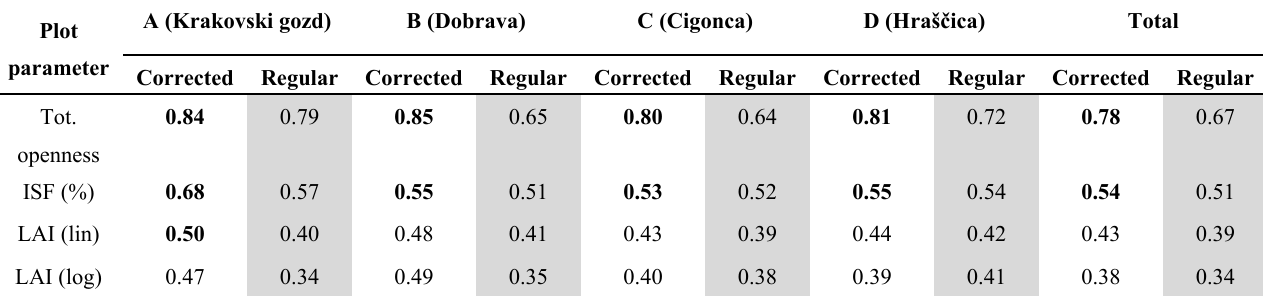
Table 2. Correlation coefficients ( r 2 ) for the agreement between average ocular estimate and parameters from hemispherical analysis. Corrected values are bold, regular ones are